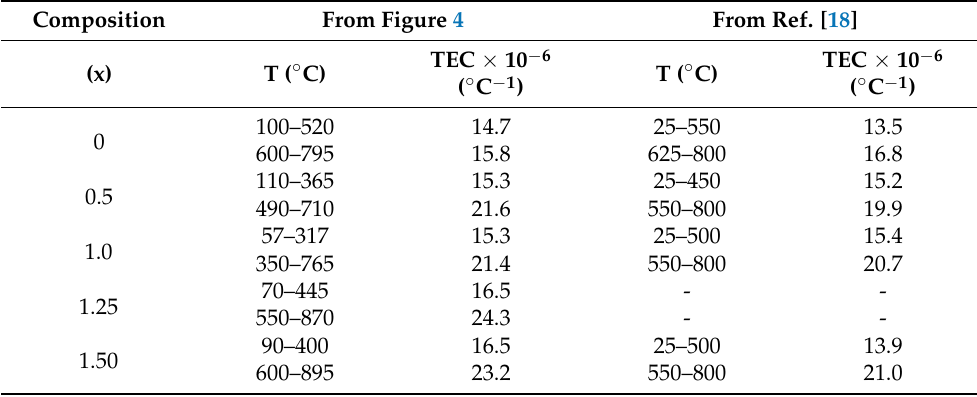
Figure 3. Variation of thermal expansion for different samples; ( a ) undoped La 2 Mo 2 O 9 , ( b ) 0.50 W; ( c ) 1.0 W; ( d ) 1.25 W; ( e ) 1.5 W. The vertical lines at 580 ◦ C represent the phase transition of undoped La 2 Mo 2 O 9 . The dashed lines indicate the linear regimes. Table 2. Thermal expansion coefficient for different W-substituted samples at different temperature regimes. The TEC, as obtained from the literature, is also shown. ‘-’ represents unavailable values in